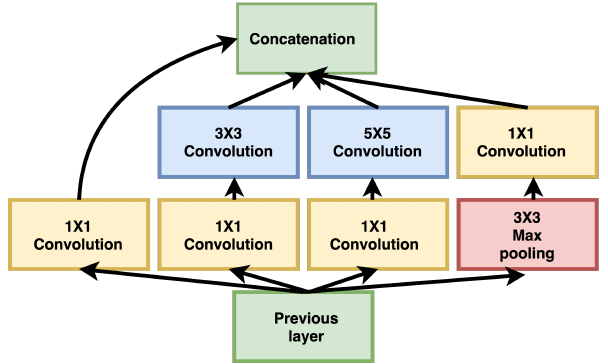
Figure 4. Inception: the basic building block of